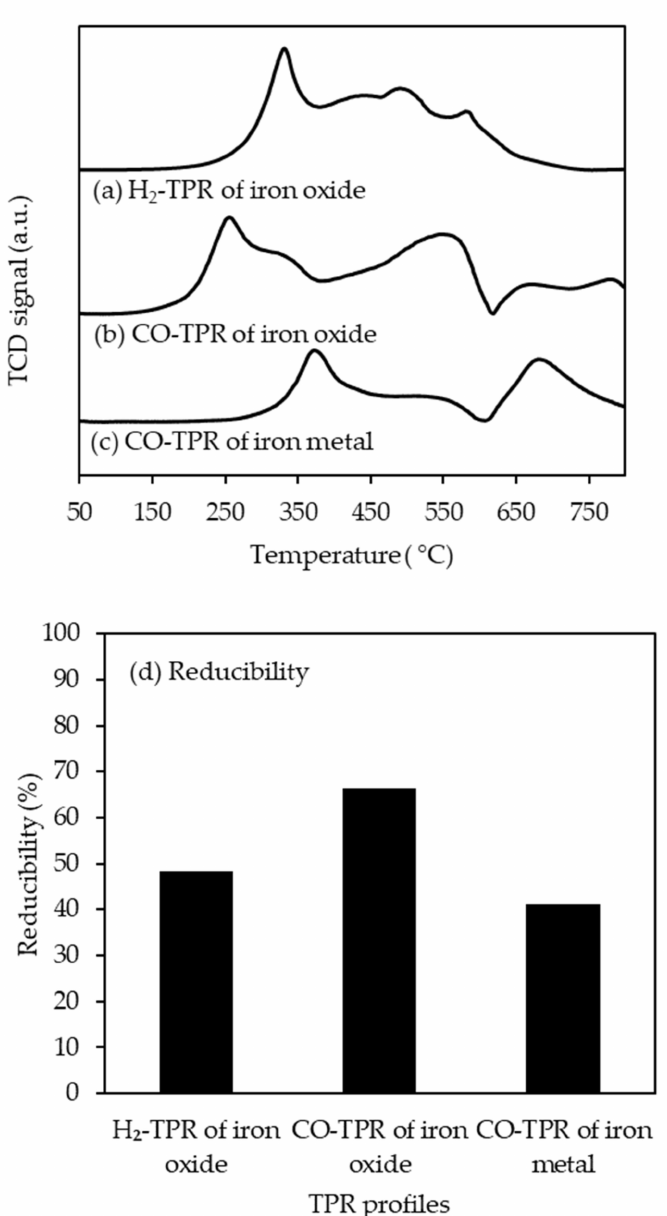
Figure 1. ( a ) H 2 -TPR profile of calcined Fe/SiO 2 catalyst, ( b ) CO-TPR profile of calcined Fe/SiO 2 catalyst, ( c ) CO-TPR profile of reduced Fe/SiO 2 catalyst, and ( d ) reducibility of the different TPR profiles of Fe/SiO 2